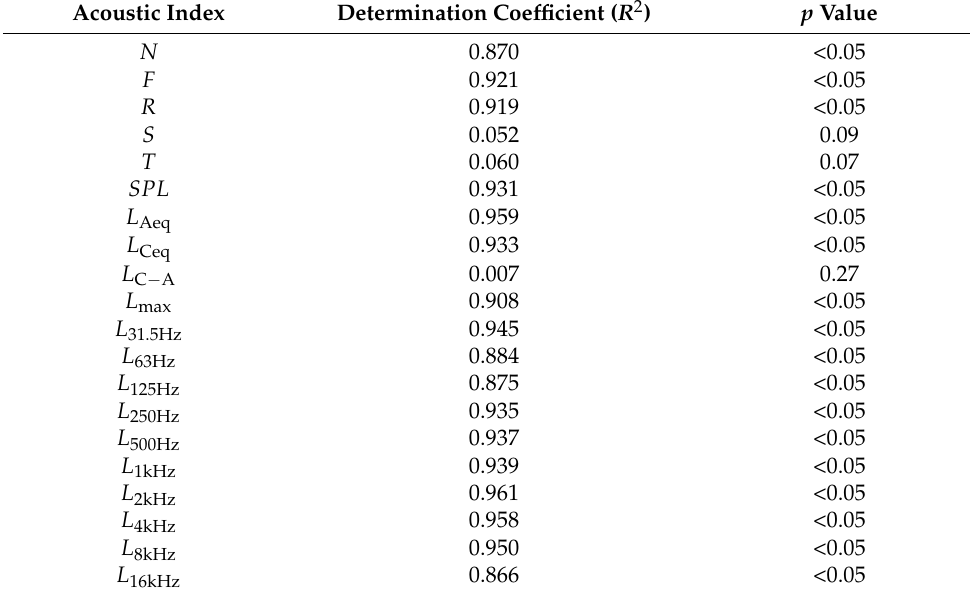
Table 3. The correlation between substation noise annoyance and each acoustic